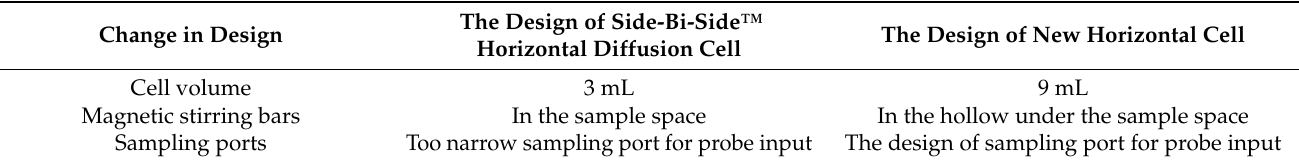
Table 4. The design of the horizontal diffusion cell to optimize it for inline nasal powder penetration measurements. Change in Design